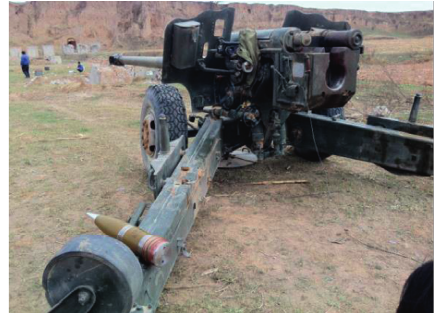
Figure 12: The artillery.